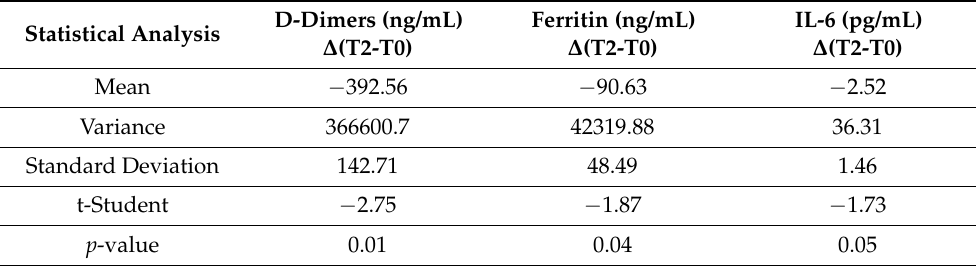
Table 5. Parameters showing significant variations between T2 and T0 in liposomal bovine lactoferrin (bLf)-treated COVID-19 patients.